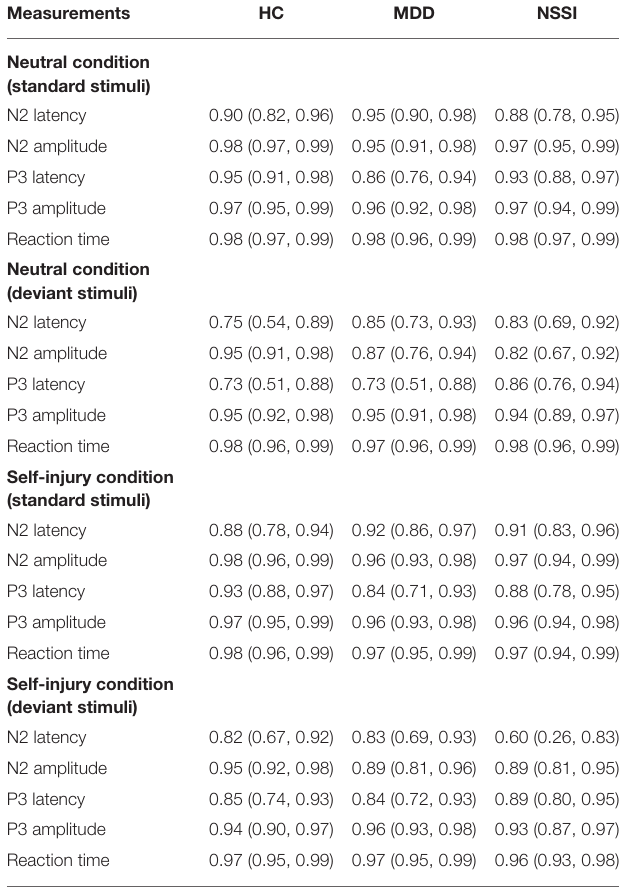
TABLE 2 | Reliability estimates for electrophysiological and behavioral